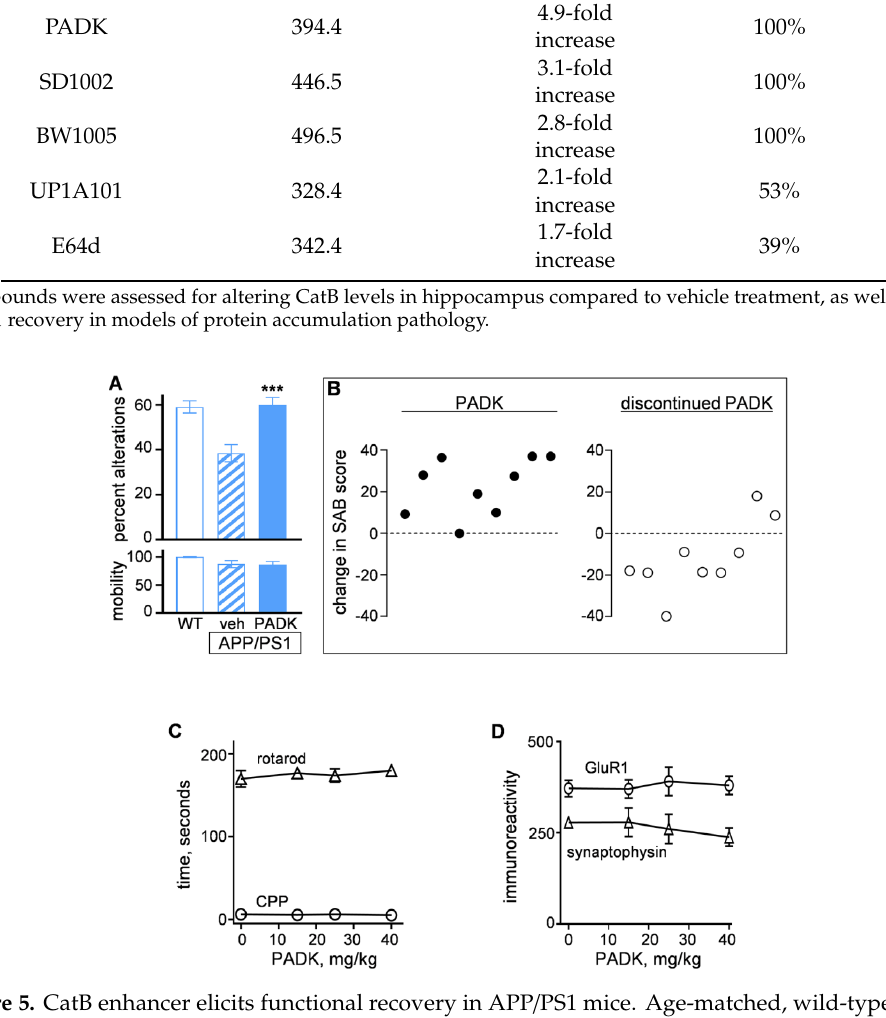
Table 1. Small-molecule cathepsin B (CatB)-enhancing compounds promote synaptic